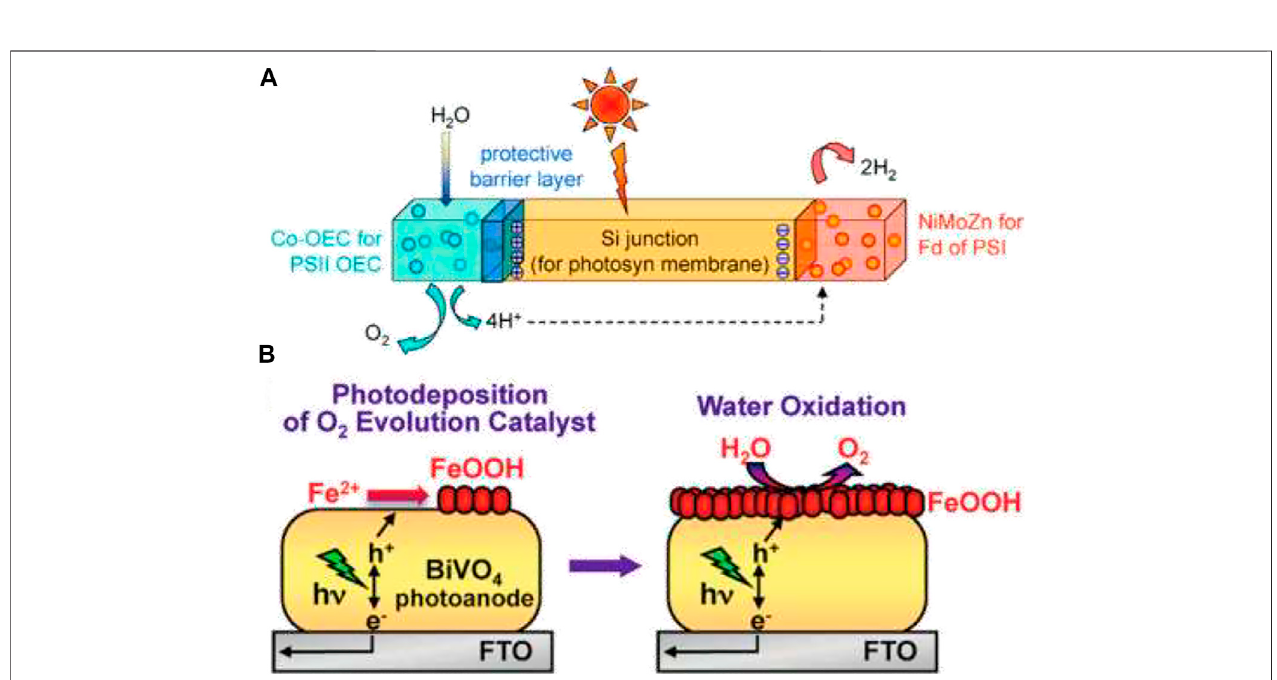
FIGURE 9 | (A) Construction of an arti fi cial leaf. The photosynthetic membrane is replaced by a Si junction, which performs the light capture and conversion to a wirelesscurrent.Theoxygen-evolvingcomplexandferodoxinreductaseofthephotosyntheticmembranearereplacedbyCo-OECandNiMoZnOERandHERcatalysts, respectively, to perform water splitting. Reprinted (adapted) with permission from (Nocera, 2012). Copyright (2012) American Chemical Society. (B) Photo-oxidation of water by a bismuth vanadate photoanode coupled with an iron oxyhydroxide oxygen evolution catalyst. Reprinted (adapted) with permission from Seabold and Choi (2012). Copyright (2012) American Chemical